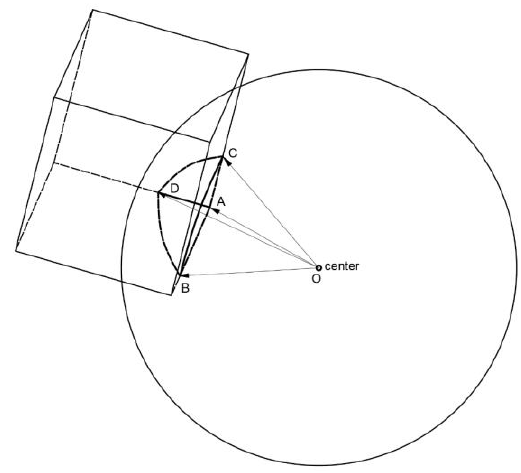
Figure A1. 3D solid fraction calculation.